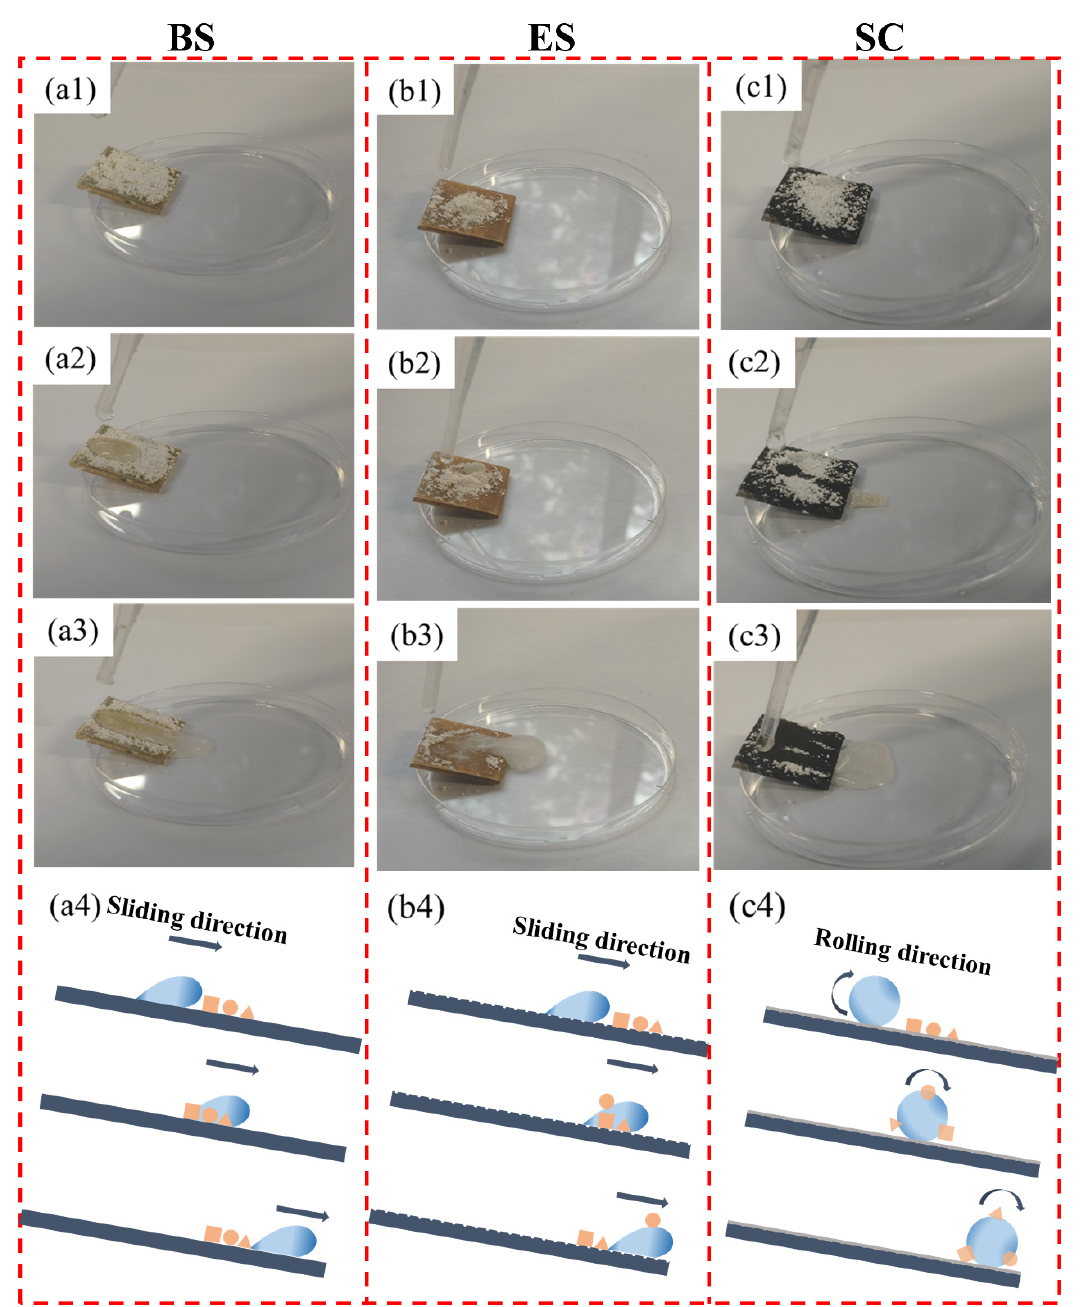
Figure 6. Self-cleaning tests and schematic diagrams on BS, ES, and SC against solid contaminants: ( a1 – a3 ) test process on BS; ( b1 – b3 ) test process on ES; ( c1 – c3 ) test process on SC; ( a4 , b4 , c4 ) show the schematic diagrams of the interaction mode with the water droplets and the contaminant particles on BS, ES, and SC, respectively.